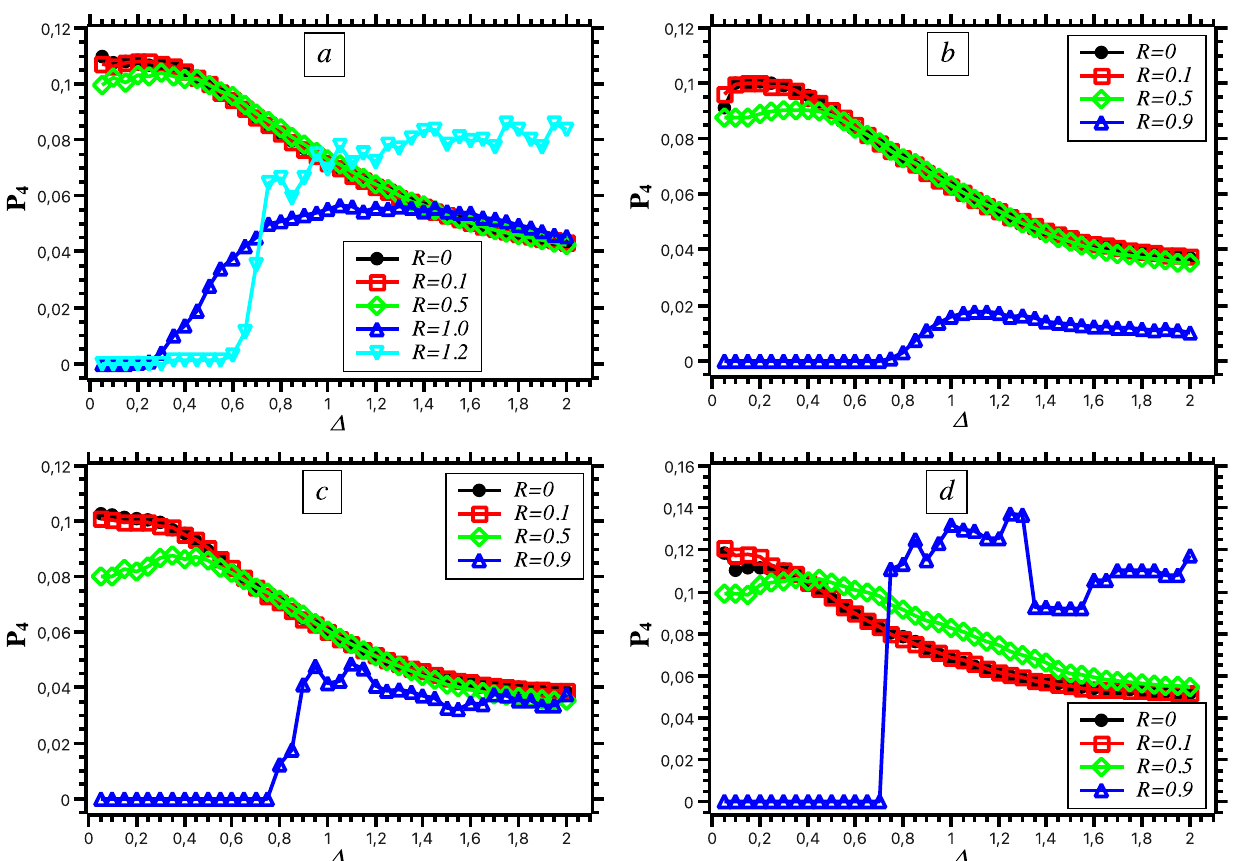
Fig. 3 The degree of alignment P 4 for the four points as a function of the disbalance Δ at the different values of the threshold R for a square ( a ) and for an ellipse with the different eccentricities e = 0 ( b ), e = 0 . 2 ( c ) and e = 0 . 5 ( d )